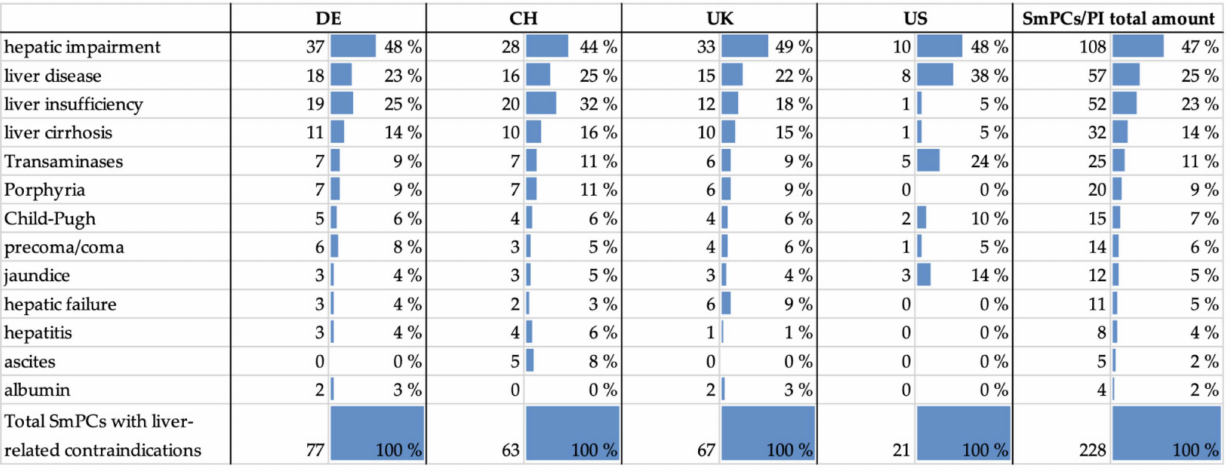
Figure 6. Number of SmPCs/PI with terms in assigned categories divided by drug